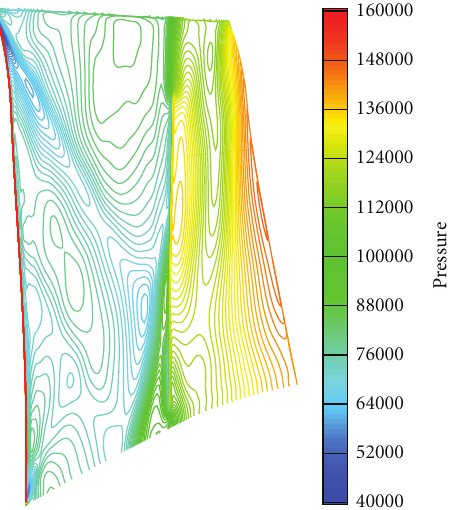
F 14: Rotor two axisymmetric blade suction surface static pressure contours for the adiabatic aspirated case.